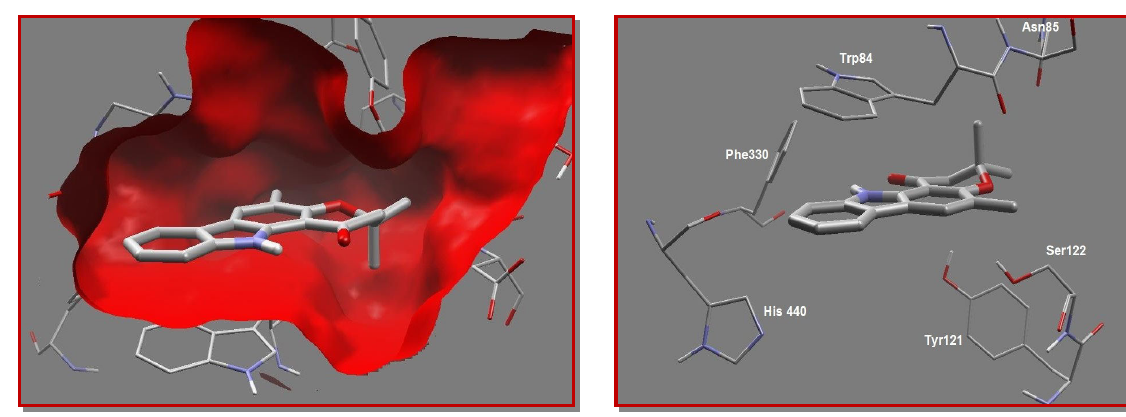
Figure 3: A closer view of molecular interactions between resi- dues inside active site of AChE with euchrestifoline (Ecf). Hy- drogen atoms except polar ones are omitted for clarity